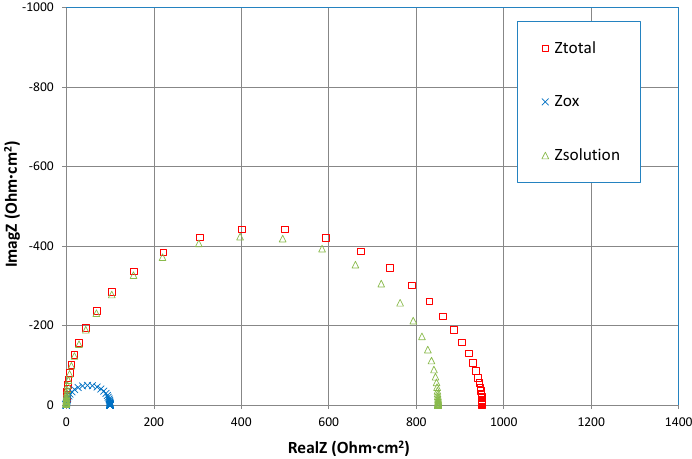
Table 4. Values for the high frequency impedance calculation.